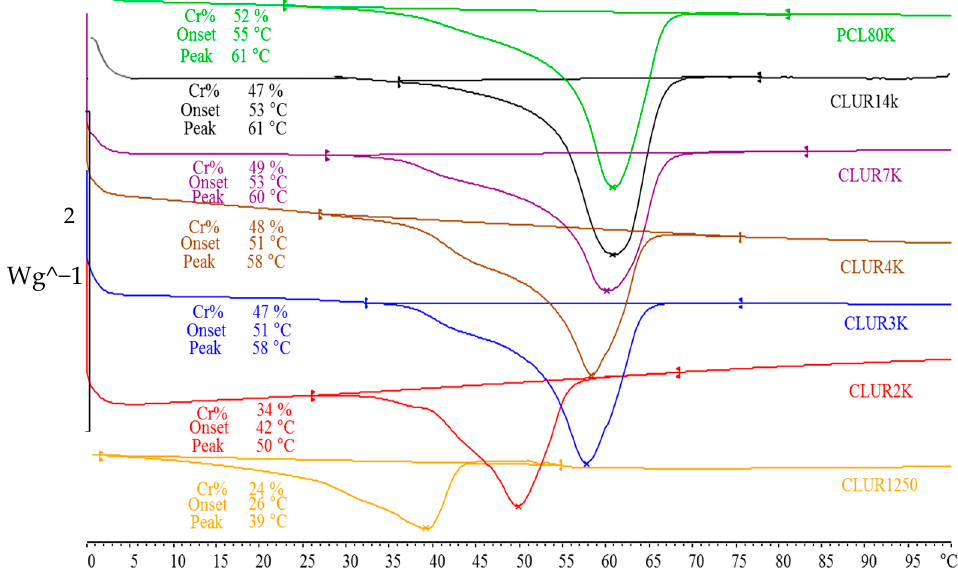
Figure 3. DSC curves of CLUR polymers based on PCL segments of different molecular weight.